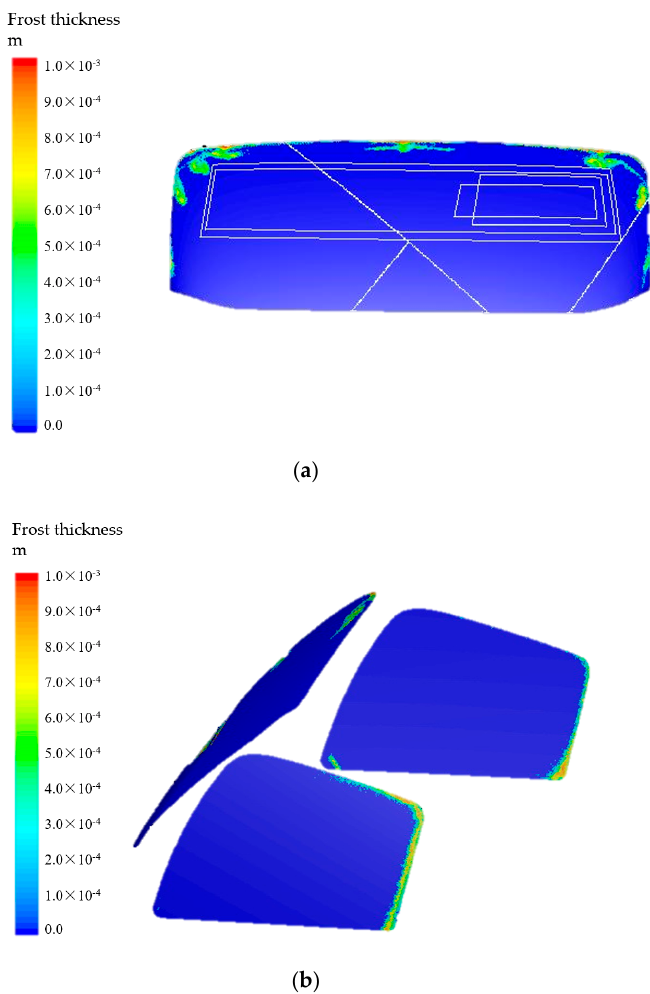
Figure 12. Frost thickness distribution on the windshield surface at 25 min after optimization: ( a ) front windshield; ( b ) side windshield.